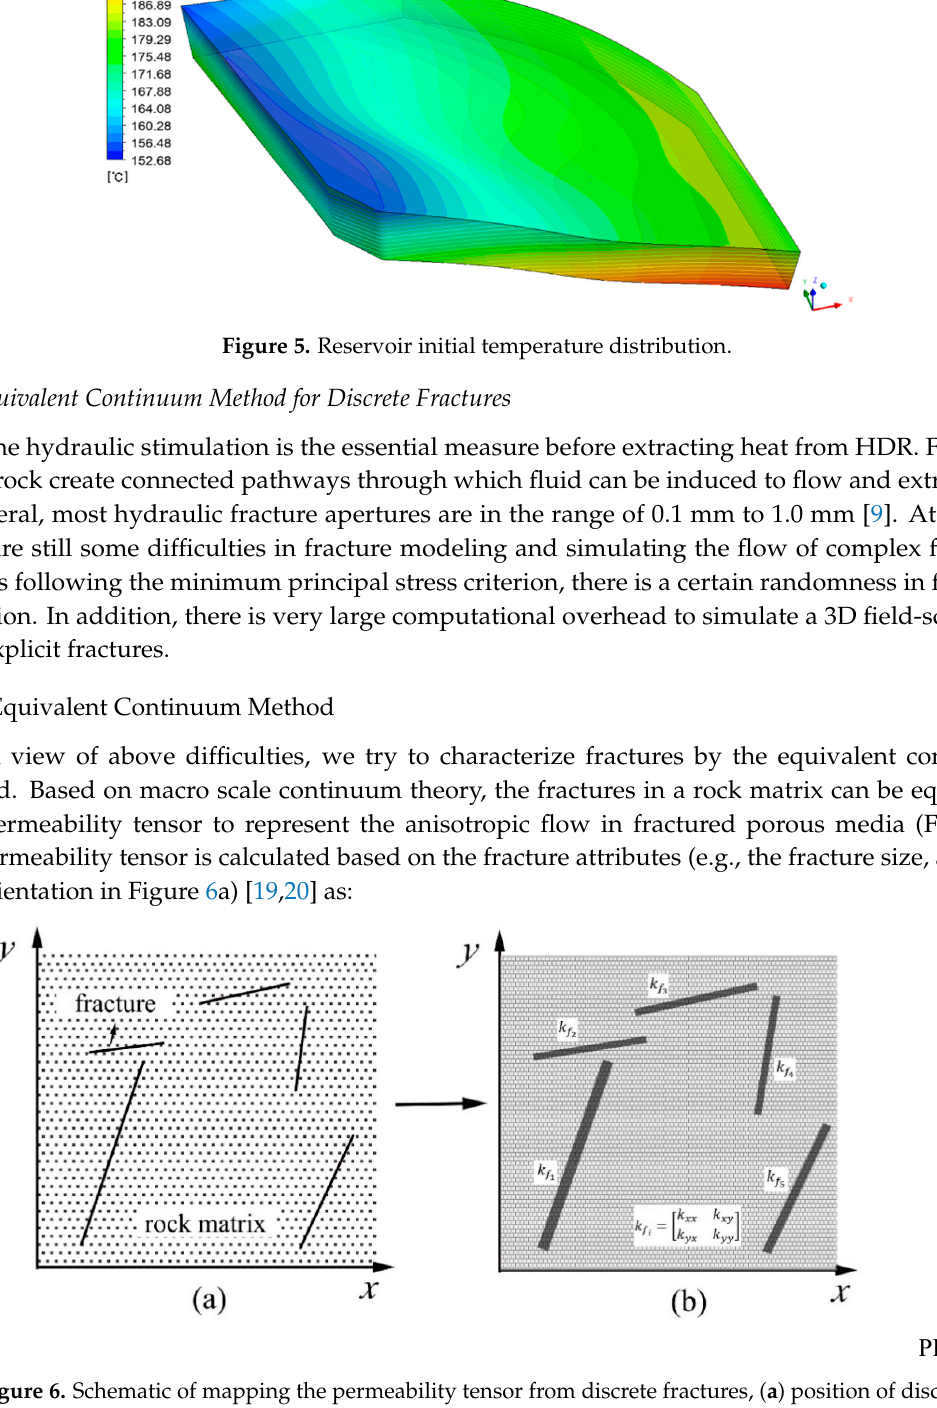
Figure 6. Schematic of mapping the permeability tensor from discrete fractures, ( a ) position of discrete fractures, ( b ) mapping the permeability tensor.